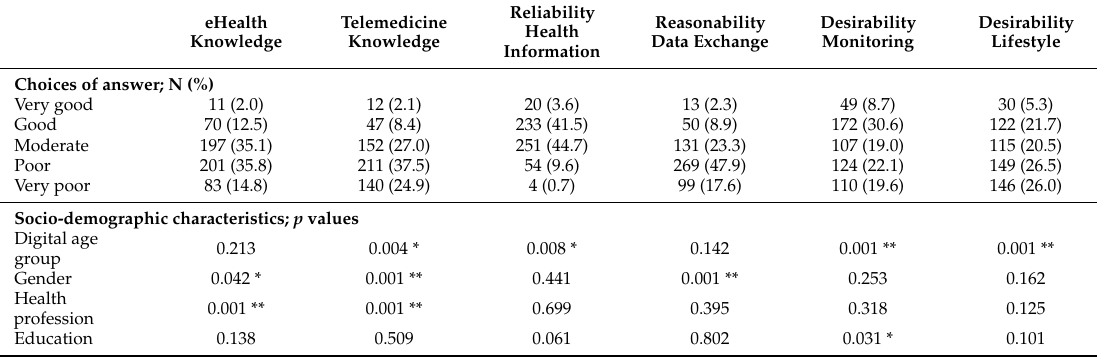
Table 5. Respondents’ views in relation to eHealth and telemedicine knowledge, reliability, and reasonability, as well as desirability monitoring and lifestyle. Reliability eHealth Telemedicine Reasonability Desirability Desirability Health Knowledge Knowledge Data Exchange Monitoring Information